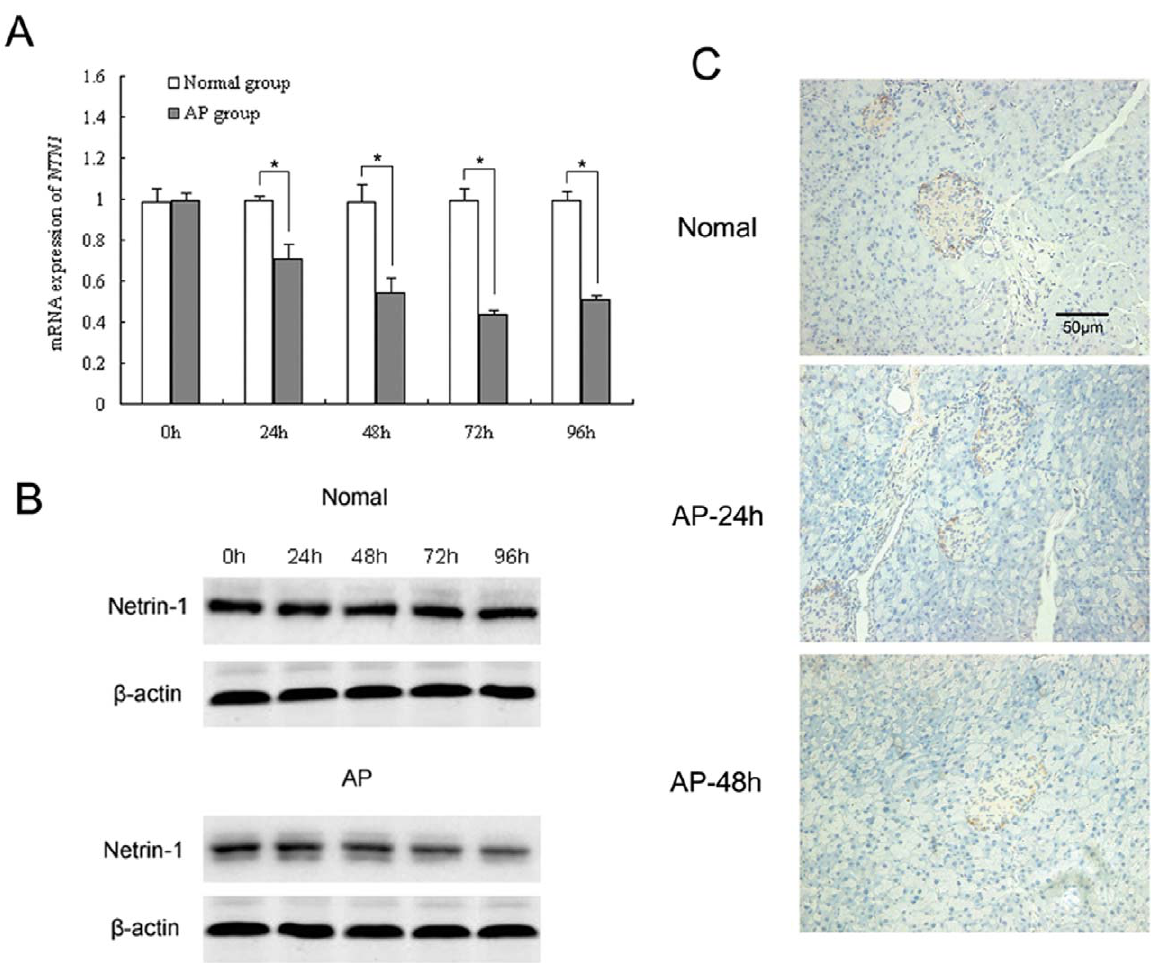
Figure 1. Expression of netrin-1 in the pancreas. RT-PCR (A) and Western blot analysis (B) of netrin-1 expression and immunohistochemical staining (C) of netrin-1 at the indicated times in mouse (C57BL/6) in normal and AP model pancreas. Acute pancreatitis was induced by two intraperitoneal injections of L-Arginine (4 g/kg, 1 h apart). Data are presented as mean 6 SD (n=6 per group in normal mice, n=8 per group in the AP model). * P ,